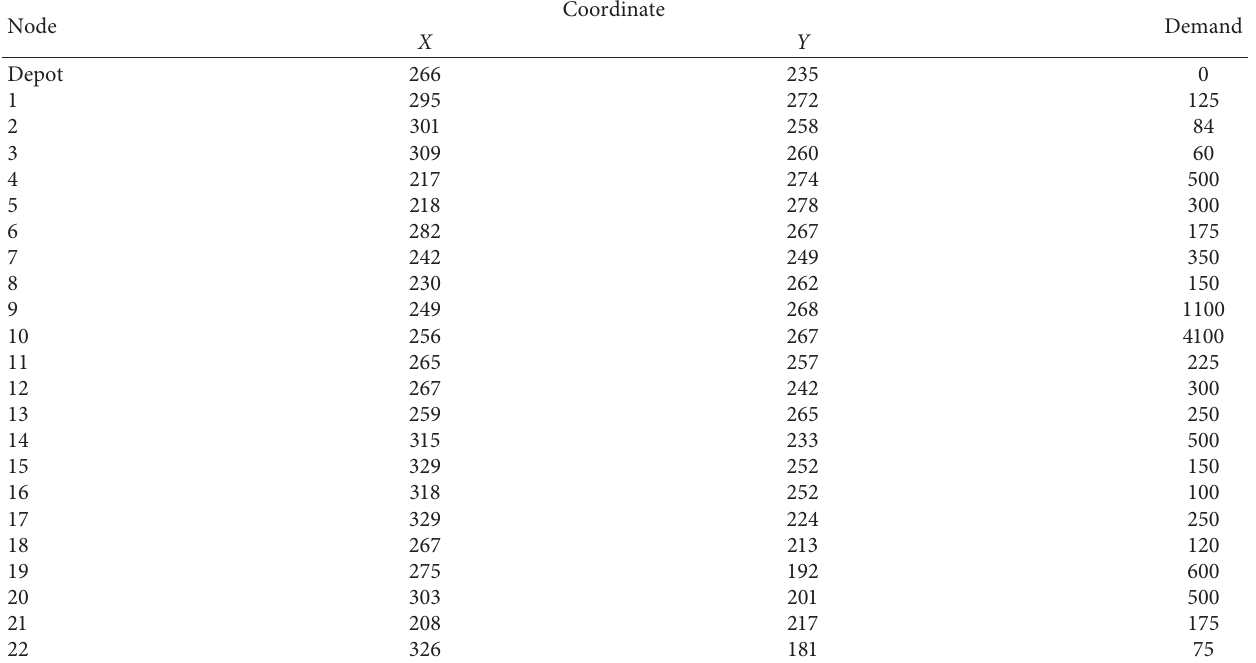
Table 1: Problem of 22